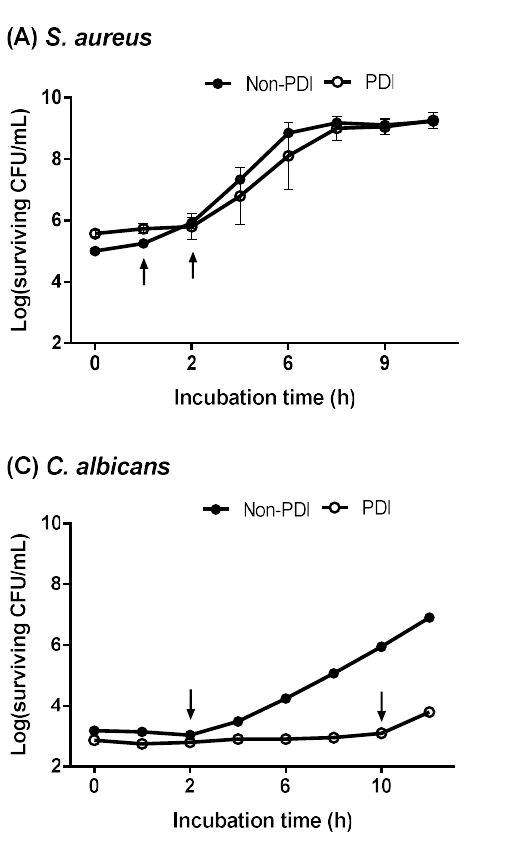
Figure 5. Prolonged recovery time in the PDI surviving cells. Cells of ( A ) S. aureus , ( B ) P. aeruginosa , and ( C ) C. albicans treated with or without PDI. For PDI, 15 μM and 20 μM TBO was incubated with S. aureus and P. aeruginosa , respectively. For C. albicans , 400 μM TBO was used for PDI. After light irradiation (50 J cm −2 ), cells were sub-cultured in a fresh culture medium. During the incubation, cells were collected every 2 h to perform plate count. Black arrows indicate the time that PDI or non-PDI treated cells enter the exponential growth phase.